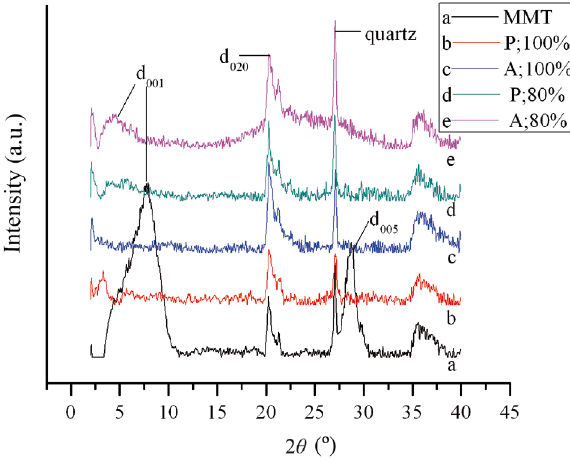
Figure 5 Fourier transform infrared (FTIR) spectra of BSA/ KH570-MMT. P, sodium phosphate buffer solution; A, sodium acetate-acetic acid buffer solution.